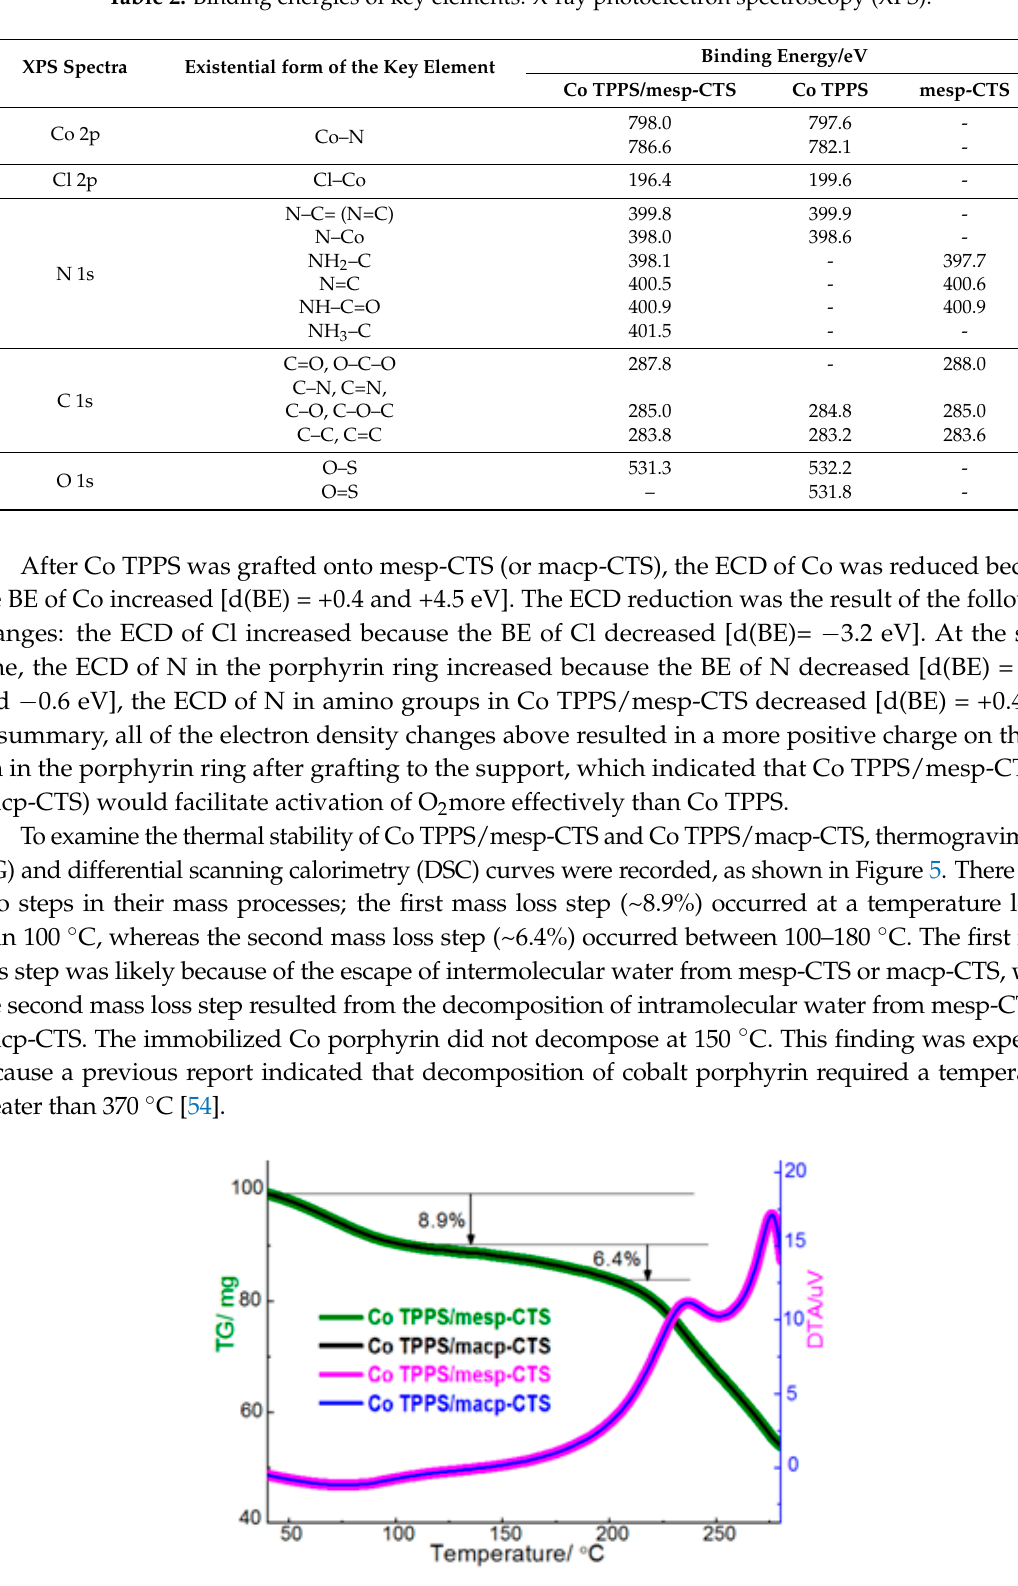
Table 2. Binding energies of key elements. X-ray photoelectron spectroscopy (XPS).